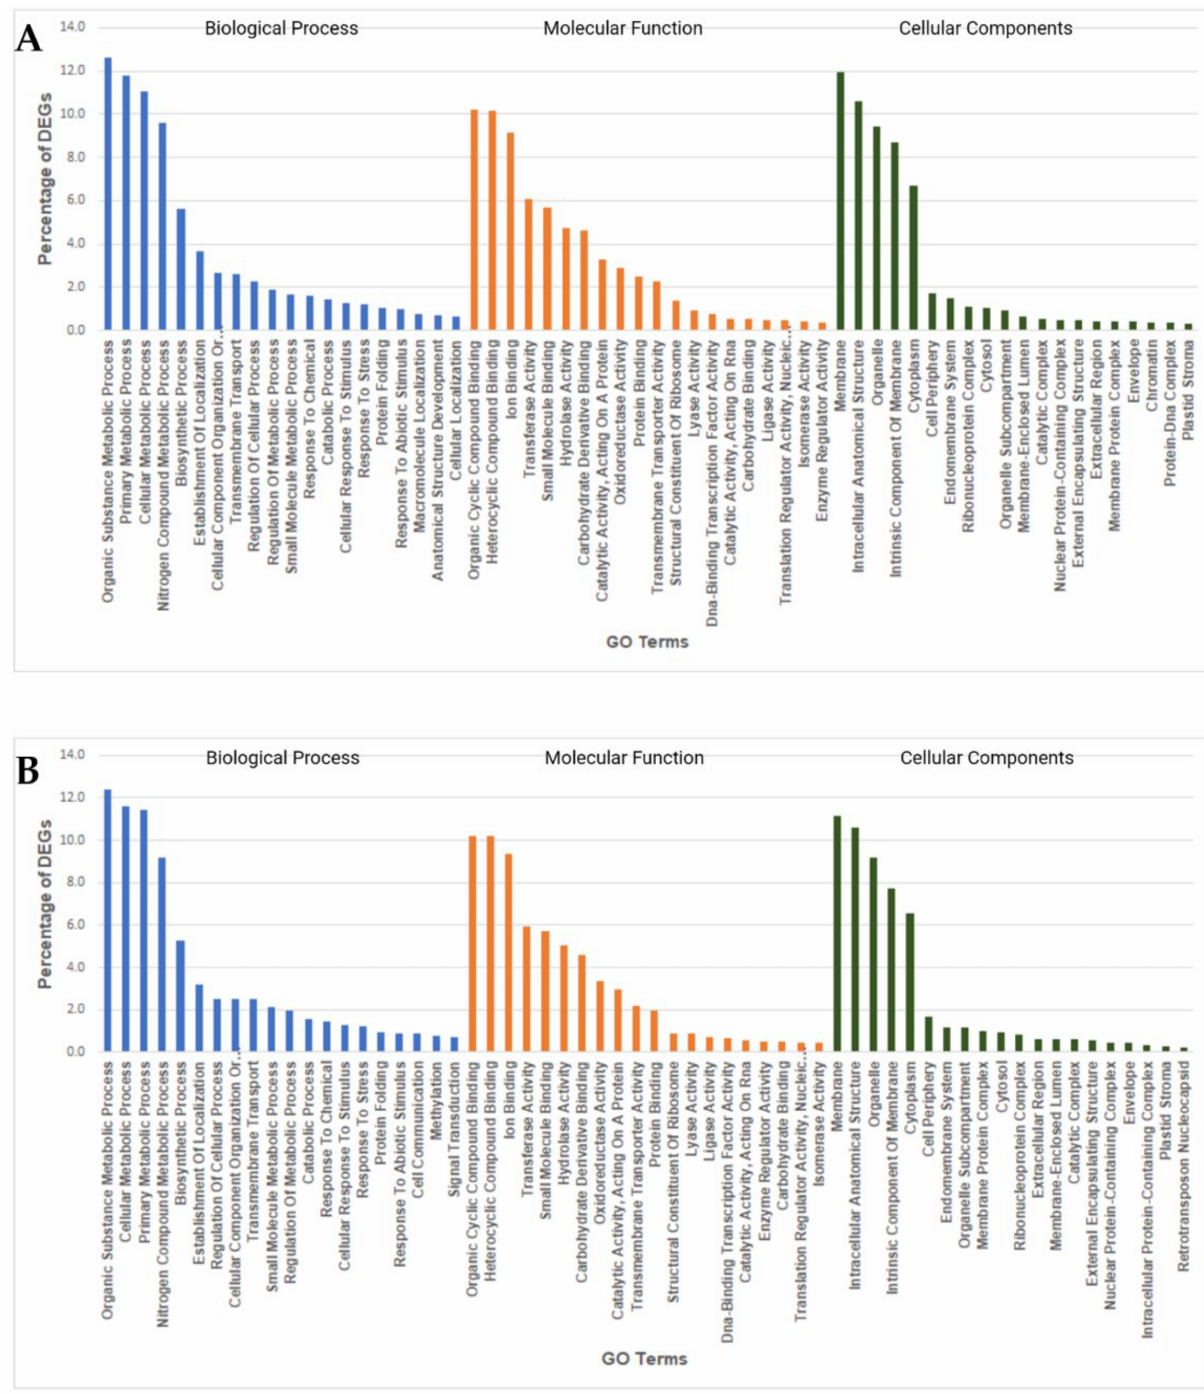
Figure 6. Gene ontology enrichment analysis of DEGs from V. corymbosum . Highly enriched Gene Ontology (GO) terms among the DEGs from V. corymbosum under 6-h heat stress ( A ) and 9-h heat stress ( B